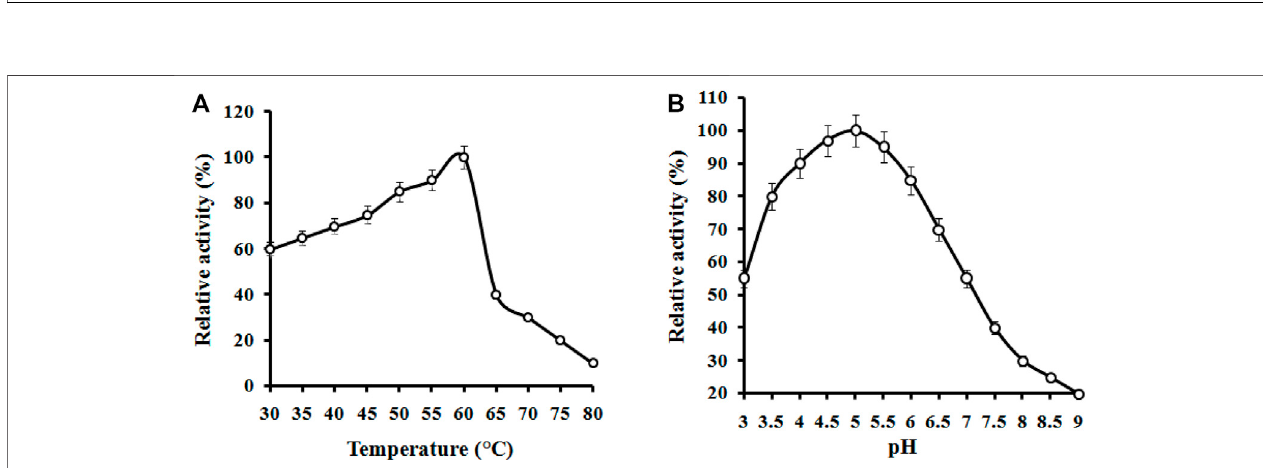
FIGURE 4 | Effects of temperature (A) and pH (B) on the activity of partially puri fi ed B. subtilis CD001 cellulase.